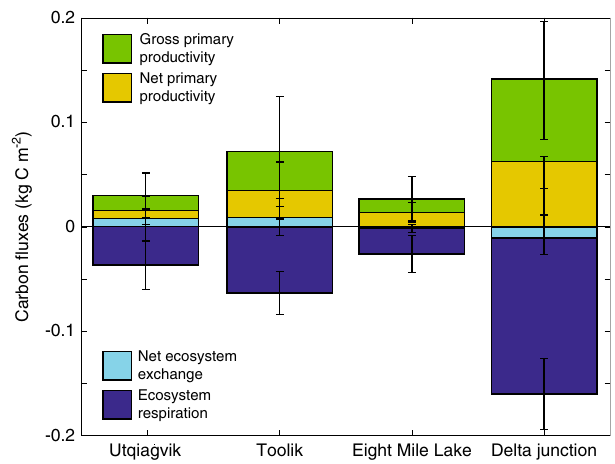
Fig. 4 Modeled plant productivity is generally smaller than elevated ecosystem respiration (autotrophic + heterotrophic respiration) under short-term warming. Short-term changes in gross primary productivity (GPP), net primary productivity (NPP), net ecosystem exchange (NEE), and ecosystem respiration (R eco ) under acute warming. The fi gure represents the mean of the different responses over 10 years (±standard